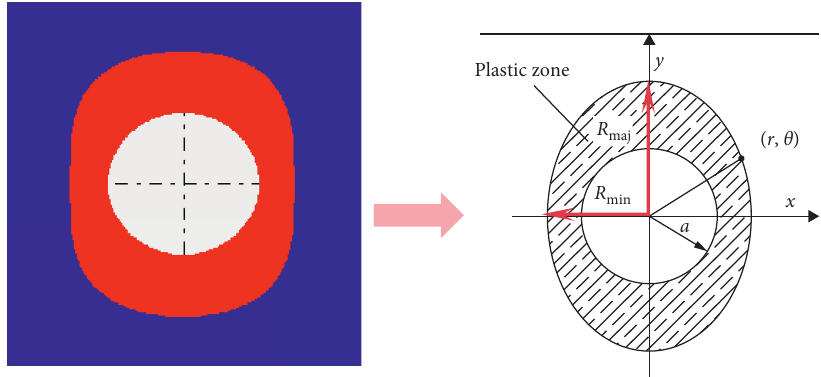
Figure 3: Elliptical distribution and special radii. (a) η � 1. (b) η � 1.2. (c) η � 1.4. (d) η �